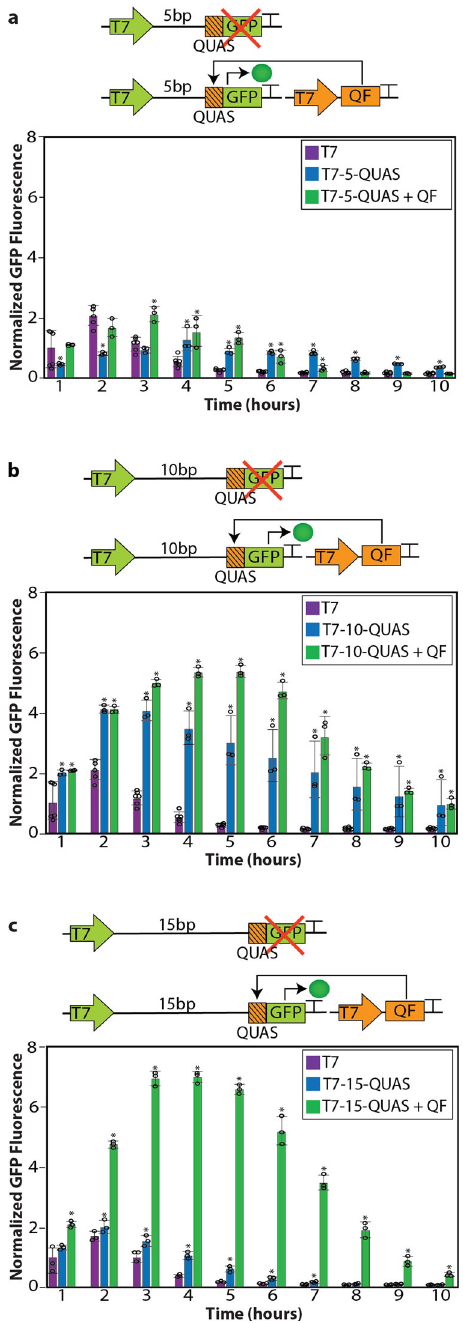
(Fig. 3). In all cases, we kept the distance between the end of the QUAS and the ribosome binding site (RBS) the same in addition to the distance between the RBS and start codon of the down- stream gene (Supplementary Table 2). The relative position of the QUAS insertion impacted the intensity and duration of GFP expression. This position-dependent effect was accentuated with the addition of QF, which resulted in the highest and most sus- tained levels of expression from T7-15-QUAS. Expression from the T7-15-QUAS + QF construct lasted 6 h longer than the T7- 15-QUAS and T7 controls (Fig. 3). While our fl ow cytometry results indicate that the bacteria maintain fairly homogeneous populations throughout this time course, after 6 h of IPTG induction of T7RNAP we could detect heterogeneity in the T7-0- QUAS and T7-0-QUAS + QF populations of bacteria with the